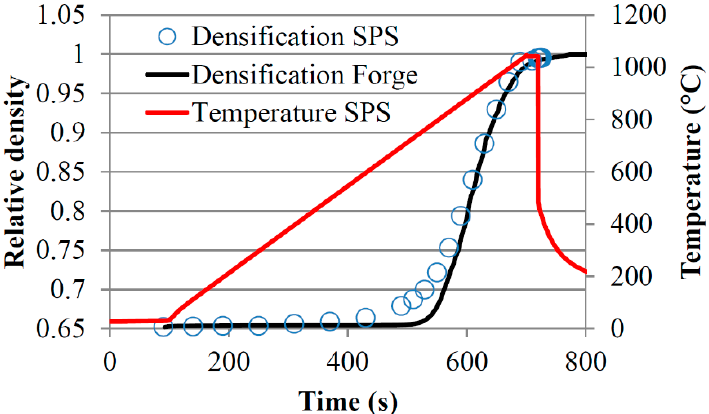
Figure 14. Densification kinetics by SPS of a TiAl alloy, compared with modeling by Forge software and continuum mechanics, using constitutive relations of bulk TiAl [85]. Reproduced with permission from Intermetallics , published by Elsevier, 2017.